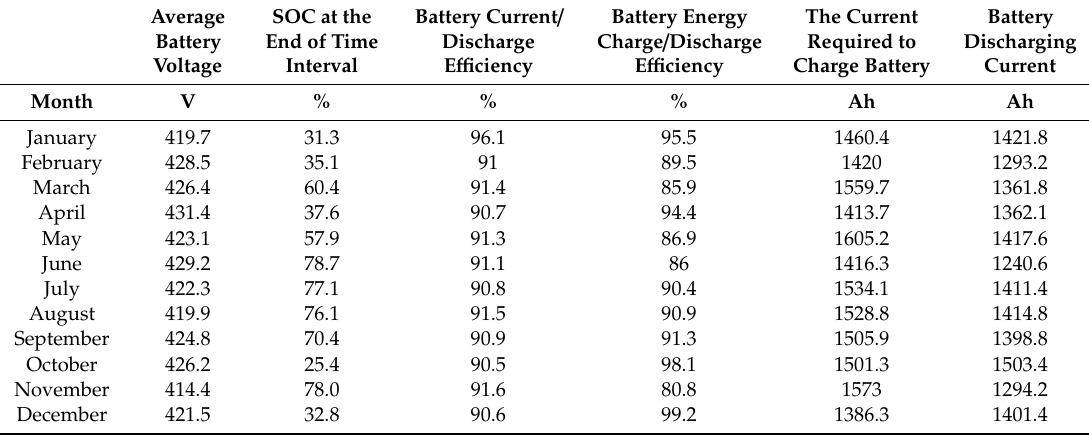
Table 4. System Battery